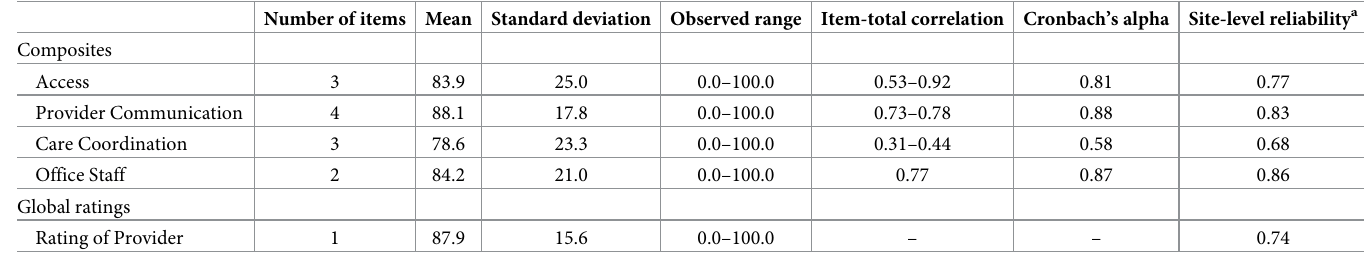
Table 4. Descriptive features, internal consistency reliability, and site-level reliability of Japanese CG-CAHPS (N =